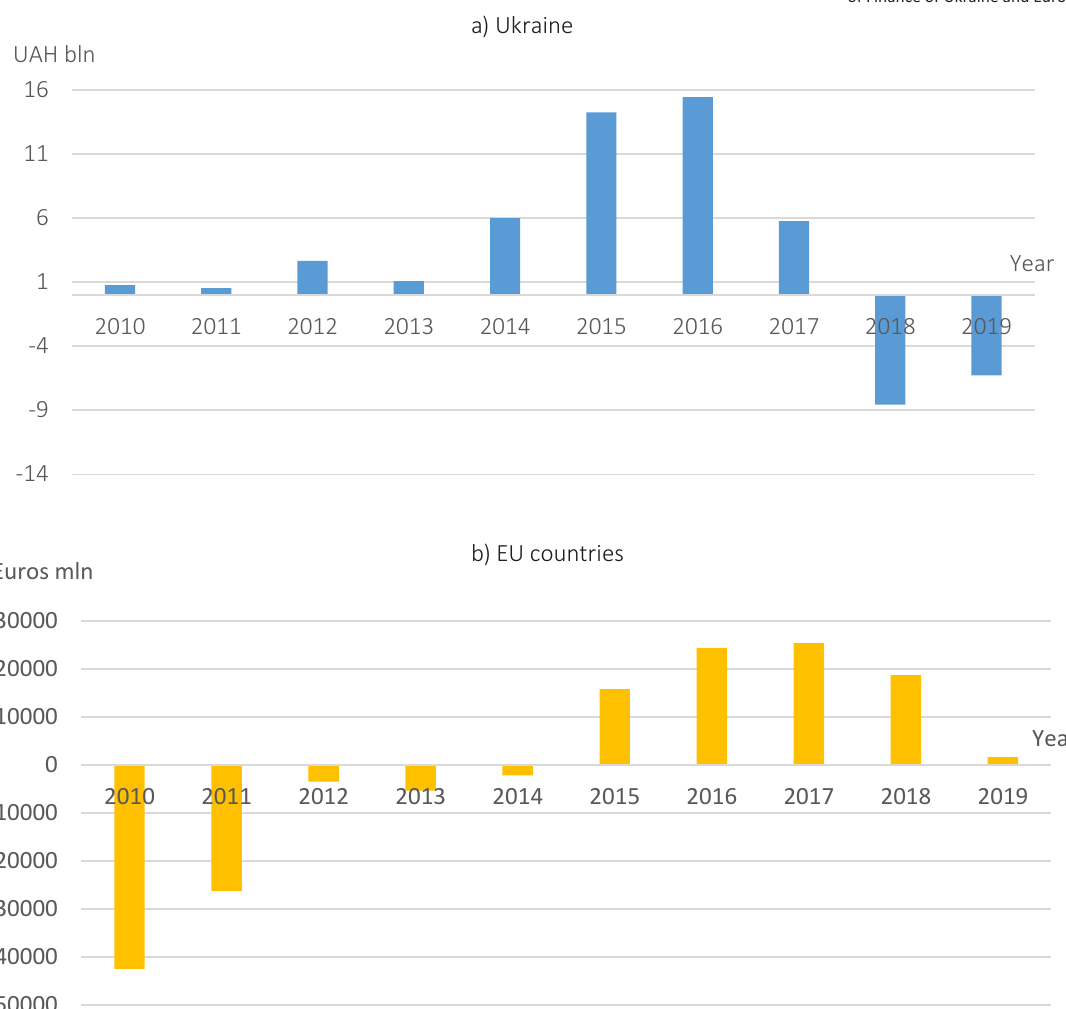
Figure 3. Comparison of local budget revenues and expenditures in Ukraine and the EU for the period 2010–2019 (surplus (+) / deficit (–))